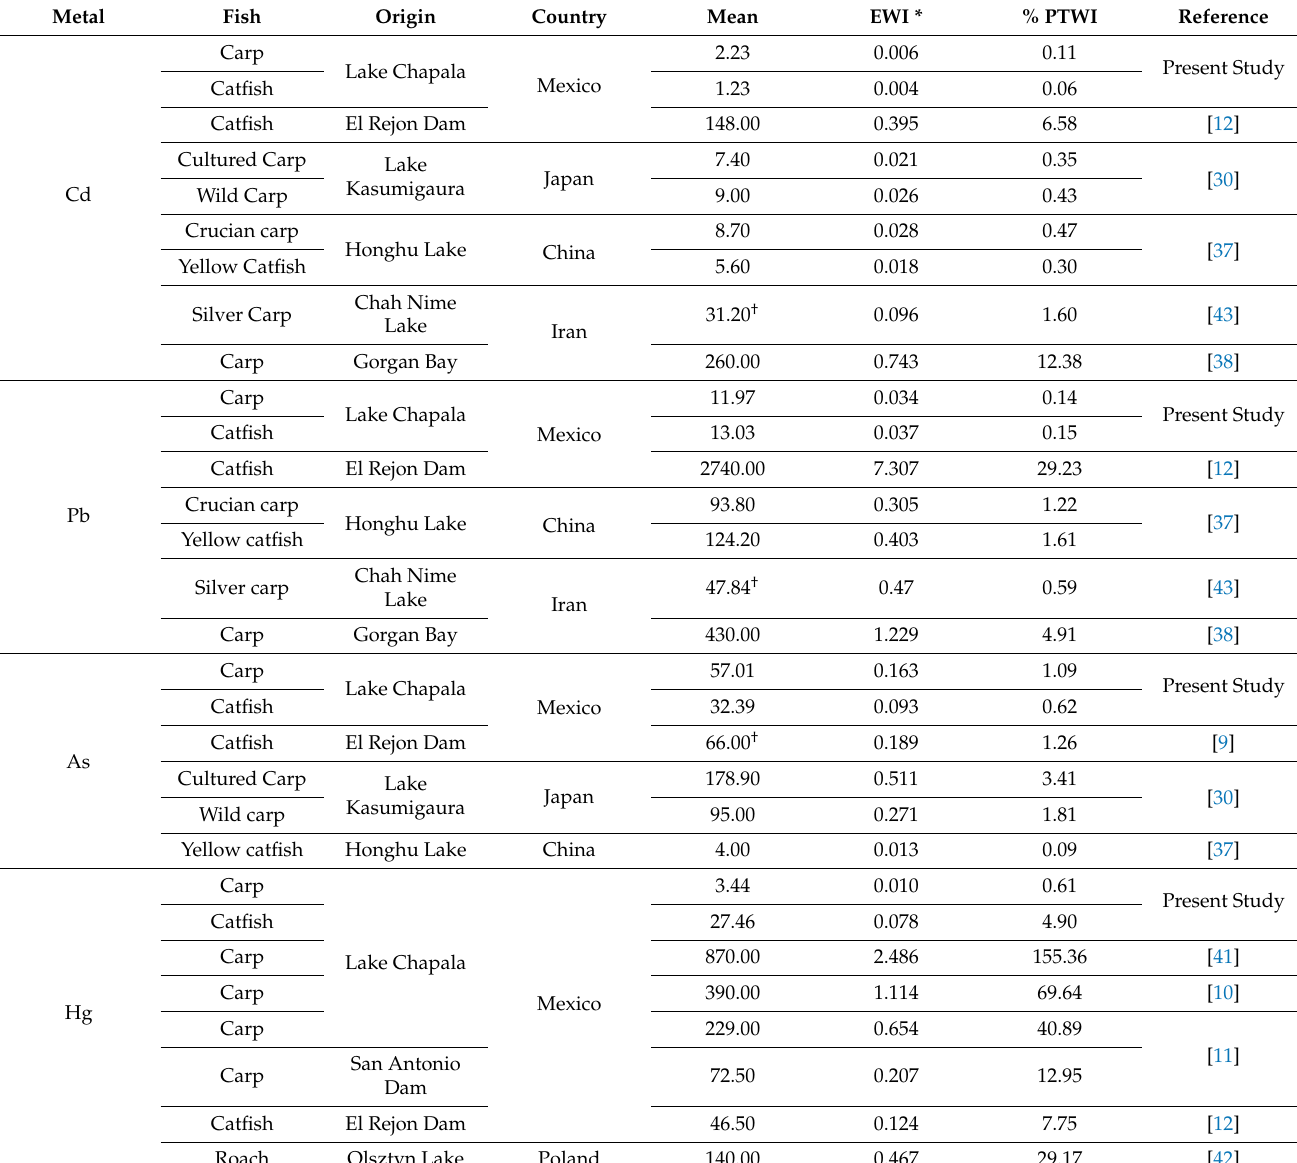
Table 6. Mean concentration ( µ g/kg ww), estimated weekly intake ( µ g/kg bw/week), and contribution to PTWI from native or cultured freshwater fish reported in previous works, compared with the present